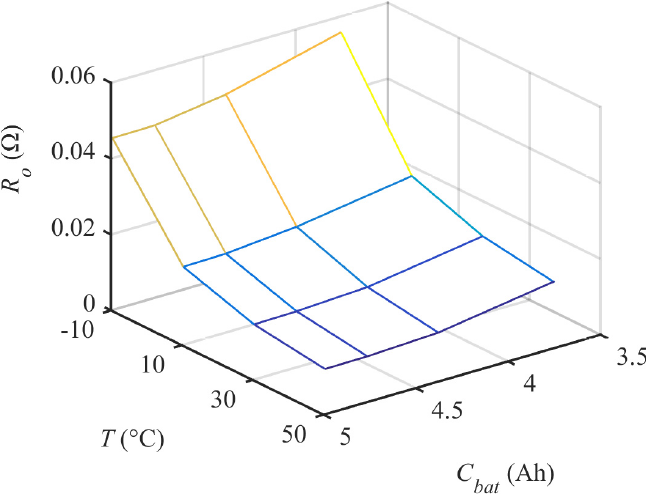
Figure 5. R o values with different temperatures at different aging levels.